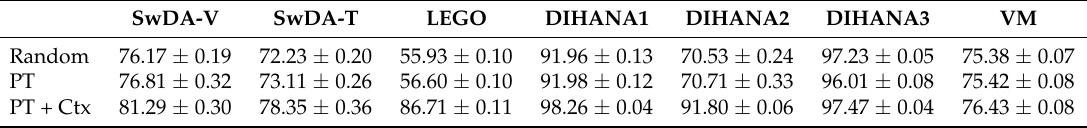
Table 6. Accuracy (%) results of the word-level baselines. The first row refers to the baseline using randomly initialized word embeddings. The second row refers to the baseline using pre-trained word embeddings (PT). The last row refers to the baseline including context information (Ctx). SwDA-V